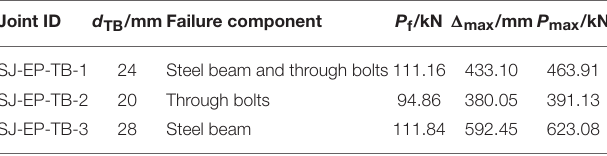
TABLE 2 | Results of joints with different diameter of through bolt.